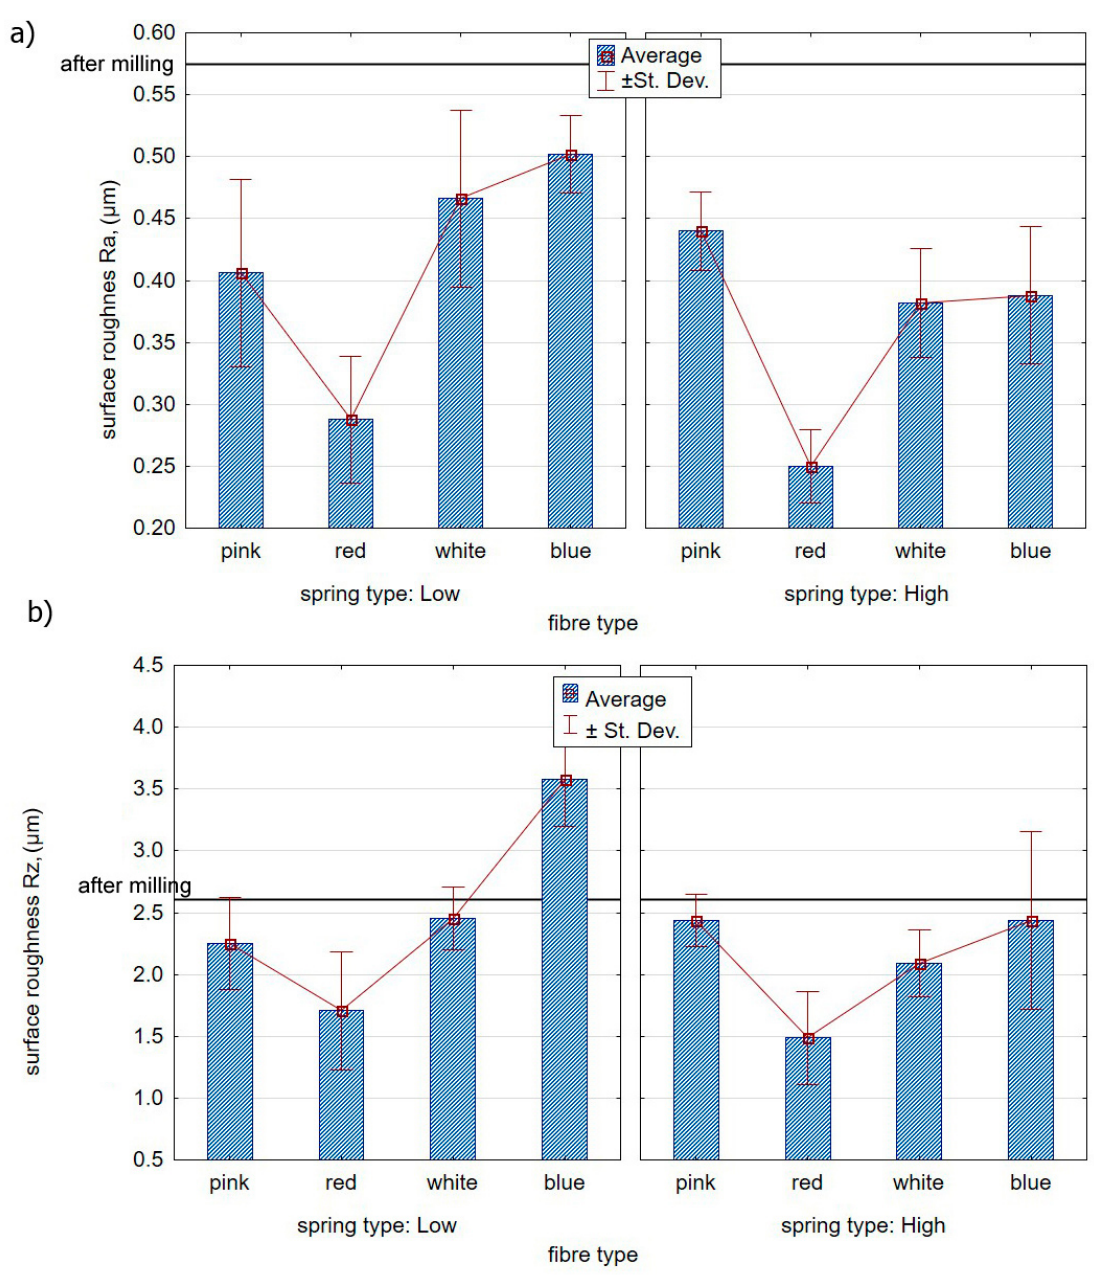
Figure 11. E ff ect of the fibre type and spring in the o ff set adjustment sleeve on the surface roughness: Figure 11. Effect of the fibre type and spring in the offset adjustment sleeve on the surface roughness: ( a ) Ra parameter; ( b ) Rz ( a ) Ra parameter; ( b ) Rz parameter.